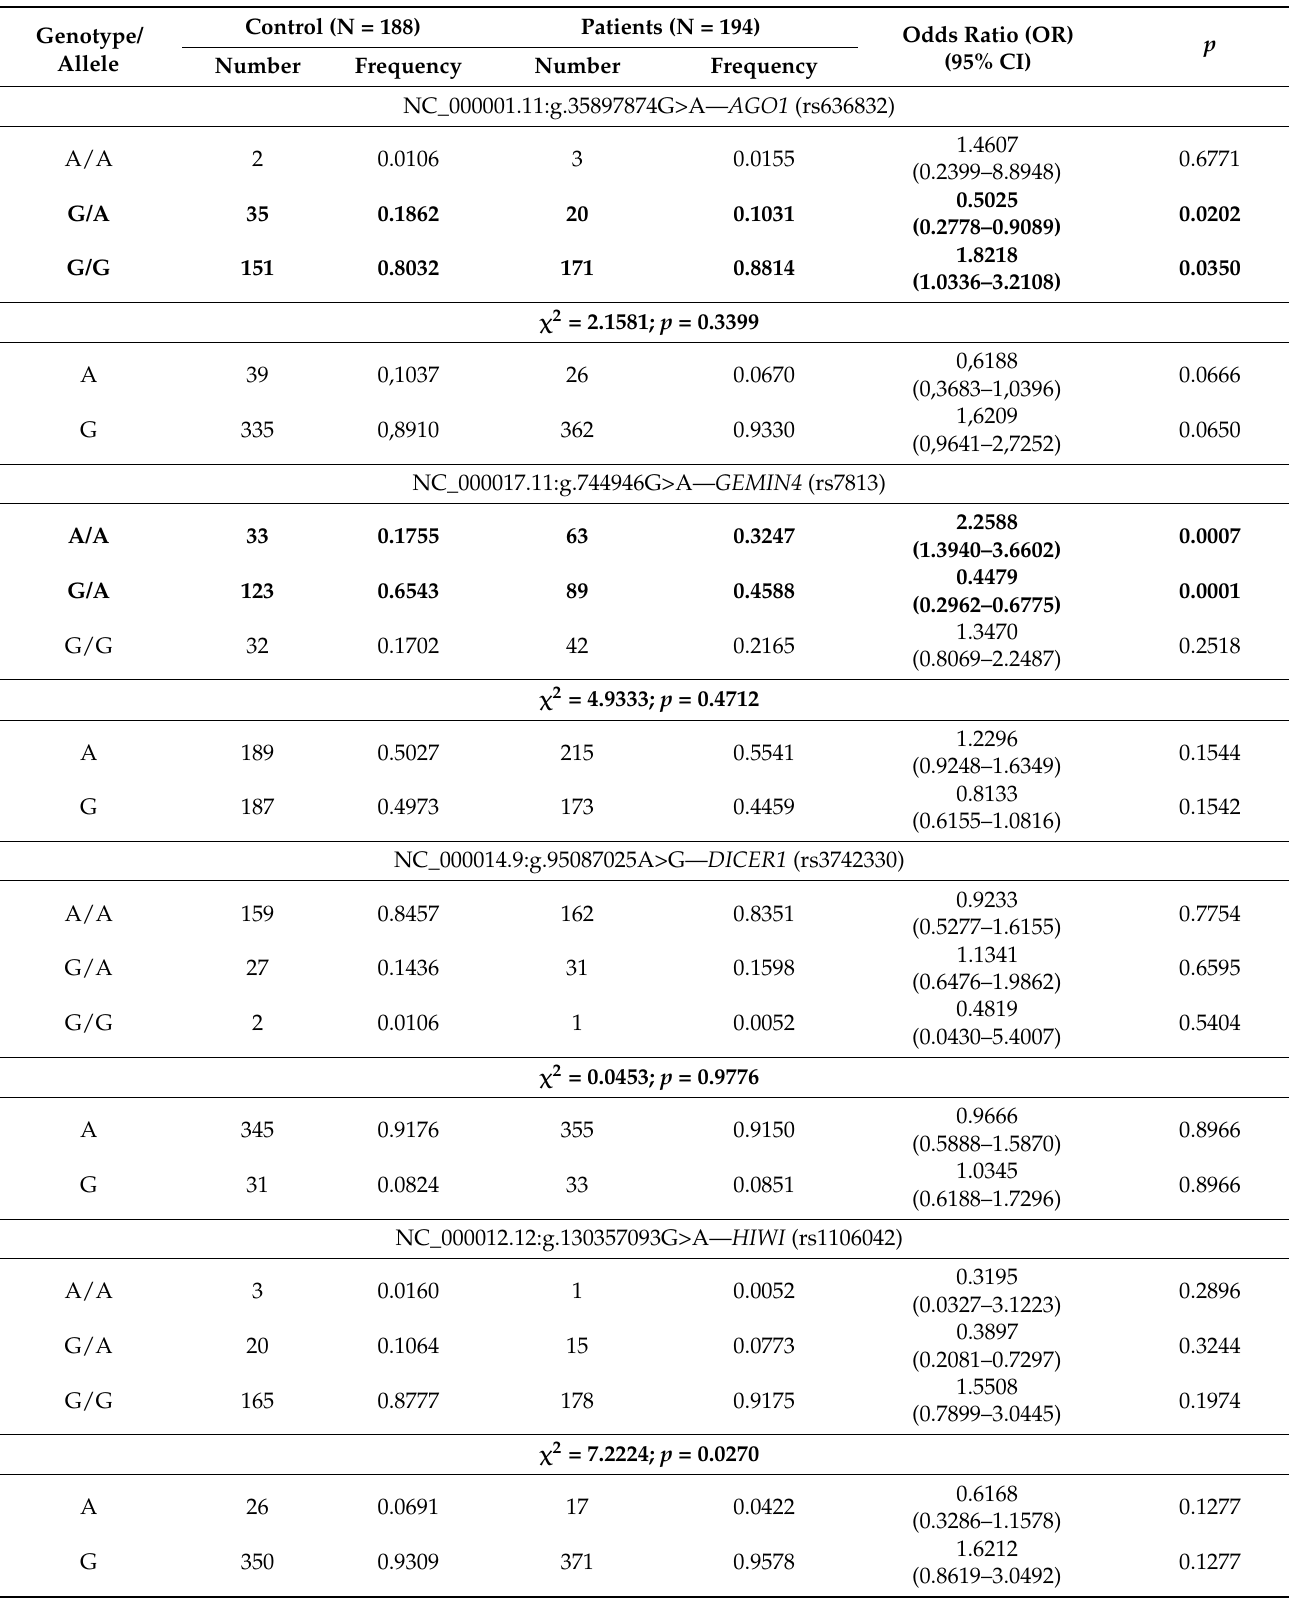
Table 3. The frequency distribution of the genetic variants of the rs636832, rs7813, rs3742330 and rs1106042 polymorphisms and their relationship with the risk of developing